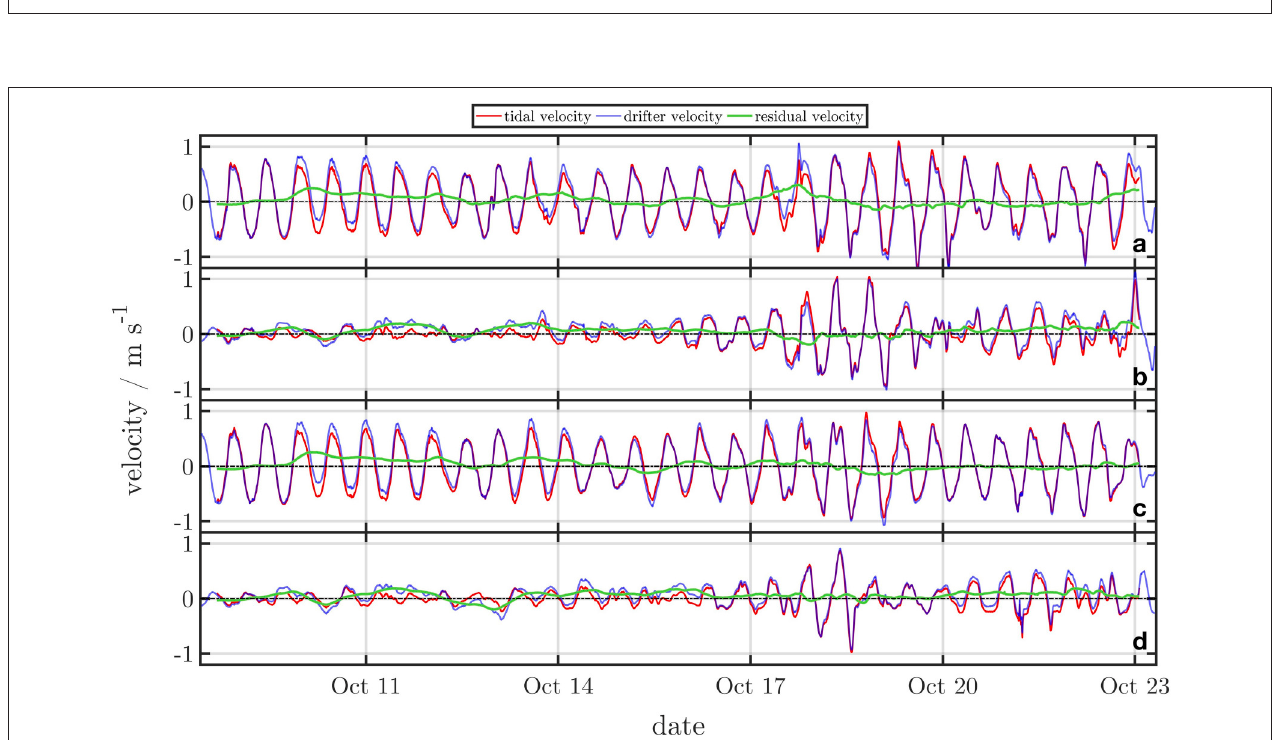
FIGURE 9 | Time series of drifter-derived velocities (blue line) of D5 of the zonal component (A) and the meridional component (B) and D6 (C,D) . The estimated tidal velocities are indicated by the red line and the residual velocities are highlighted as a green line.